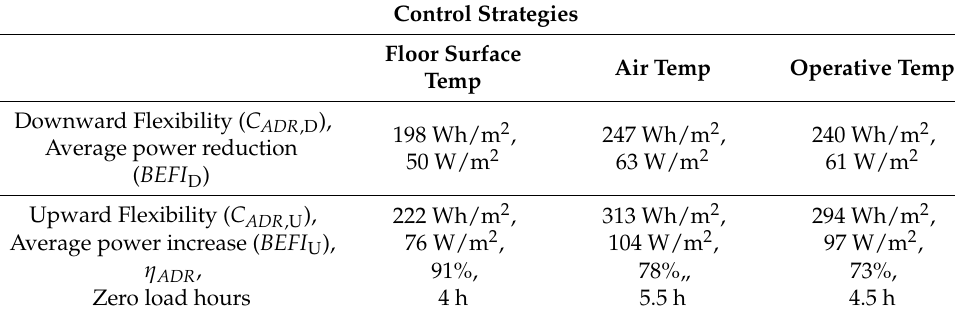
Figure 16. Downward and upward flexible case for the operative temperature control. For the downward flexible case, C ADR ,D = 240 Wh/m 2 and BEFI D = 61 W/m 2 ; and for the upward flexible case, C ADR ,U = 294 Wh/m 2 , and BEFI U = 97 W/m 2 . The storage efficiency for the rest of the day is calculated as η ADR = 73%. Table 2 sums up the results for different cases and control strategies. Table 2. Comparison of different control strategies.